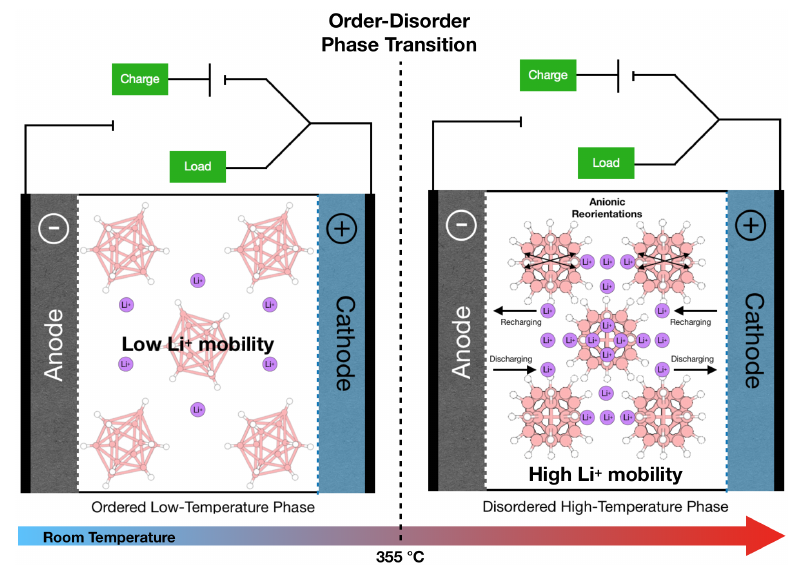
Figure 15. Schematic representation of the high-temperature order–disorder phase transition of Li 2 B 12 H 12 and its impact on the ionic conductivity in a lithium ion battery; molecular geometries for the phases sourced from [115].